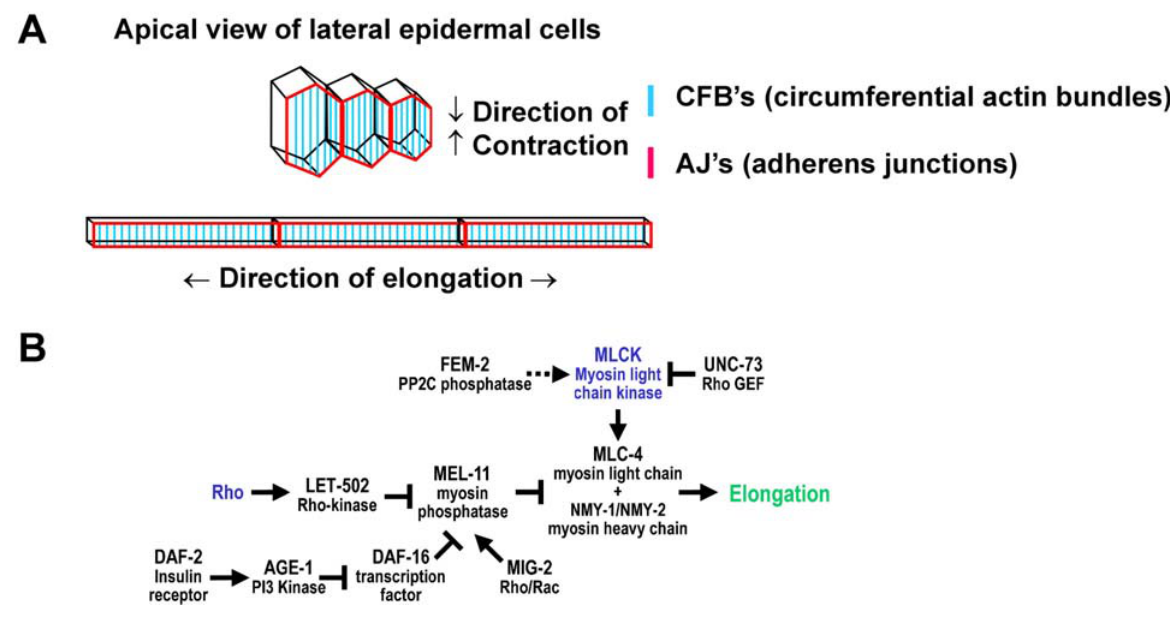
FIGURE 3 . (A) A schematic of lateral epidermal “seam” cell shape changes during elongation. The neighboring seam cells are shown at the onset of elongation, and arrows indicate the direction of CFB (in blue) contraction. Seam cells change shape, becoming longer in their longitudinal axis with a concomitant transverse shortening, resulting in a shape change in the direction of the arrows. Neighboring seam cells are linked by AJs (red). (B) The pathway of genes mediating elongation. These interactions were determined by genetic and/or molecular experiments. Positive and negative interactions are indicated by pointed and barred arrows, respectively. Genes not yet shown to interact in the C. elegans pathway are colored in blue and are placed based on analogies with other systems. Dashed arrows indicate that the interactions may not be